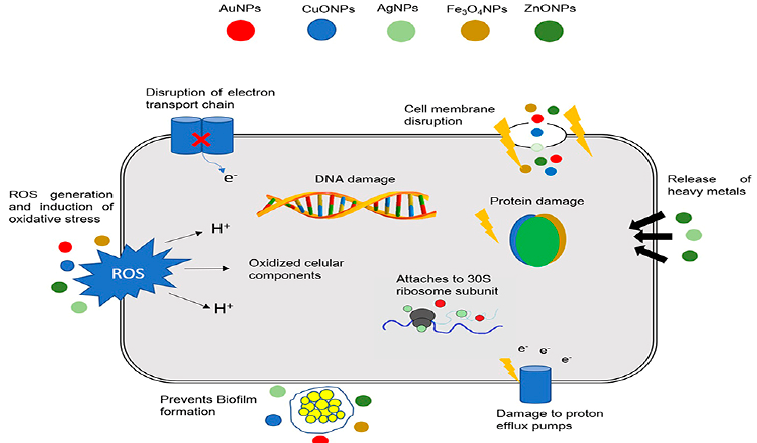
Figure 1. Antibacterial mechanisms of different nanoparticles (NPs) in fighting MDR bacteria. AuNPs: gold NPs, CuONPs: copper oxide NPs; AgNPs: silver NPs; Fe 3 O 4 NPs: iron oxide NPs, and ZnONPs: zinc oxide NPs. Reproduced from [16] under the terms of the Creative Commons Attribution License (CC BY).